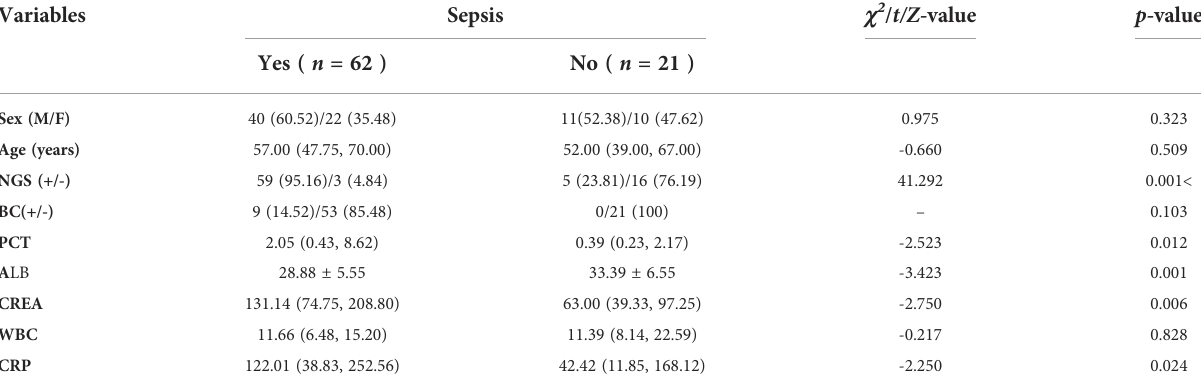
TABLE 1 Comparison of demographic and diagnostic characteristics between two groups